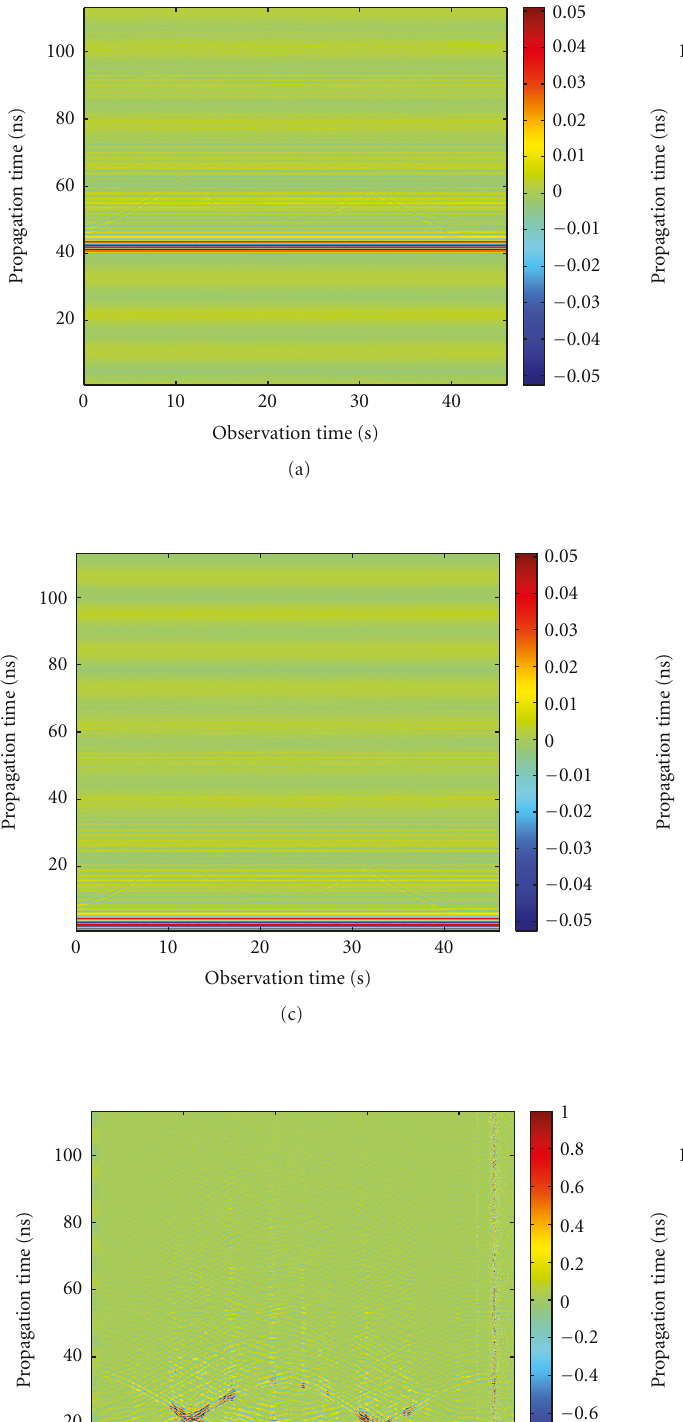
Rx Rx 1 , (f) radargram for 2